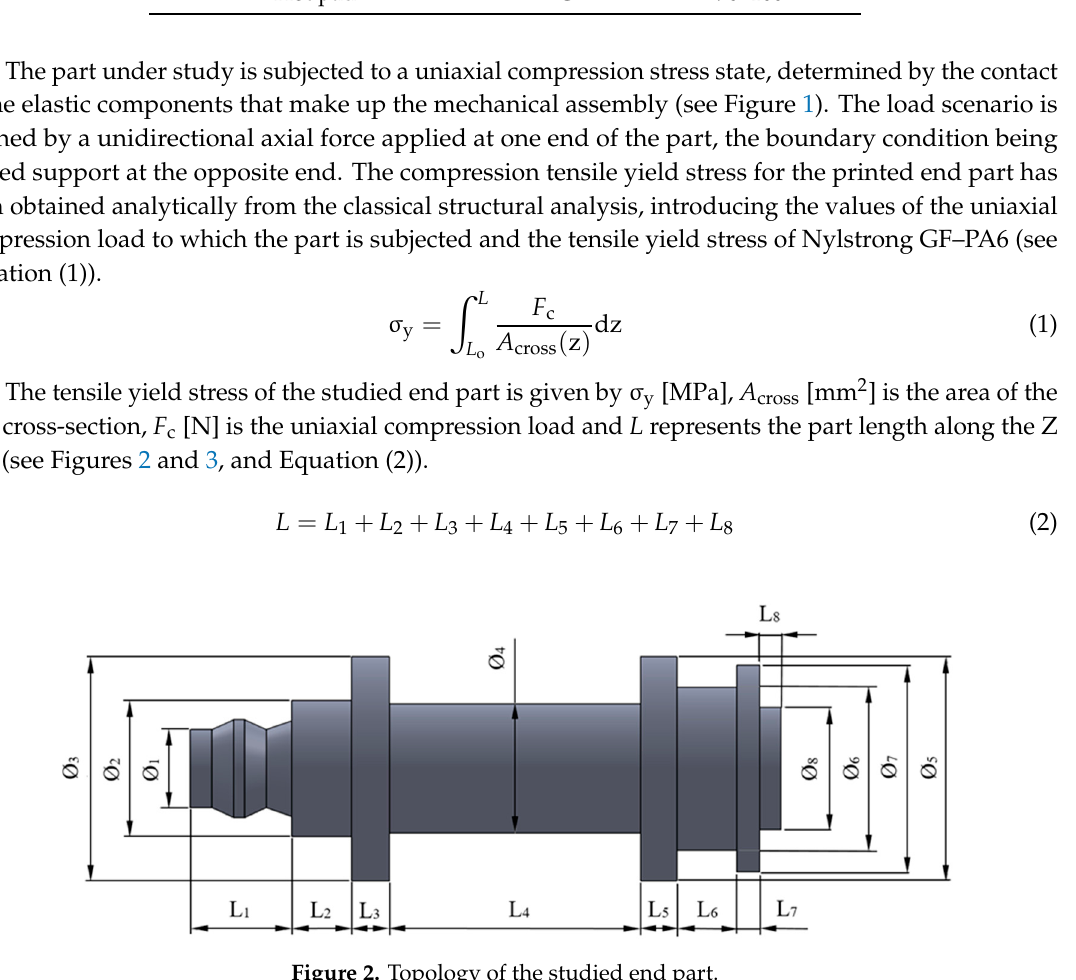
Figure 2. Topology of the studied end part.